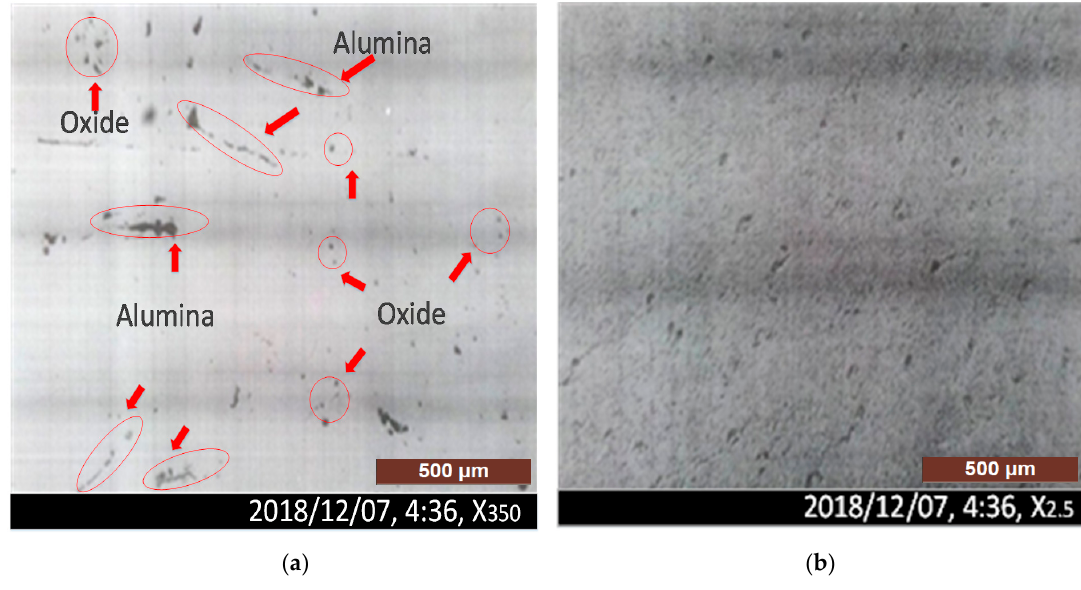
Figure 11. ( a ) Micro-inclusions, oxide and alumina-type inclusions, observed as per ASTM E-45 ( b ) The specimen was hotly etched in HCl (1:1), as inclusions were observed and randomly distributed as per ASTM E-381. The random condition is